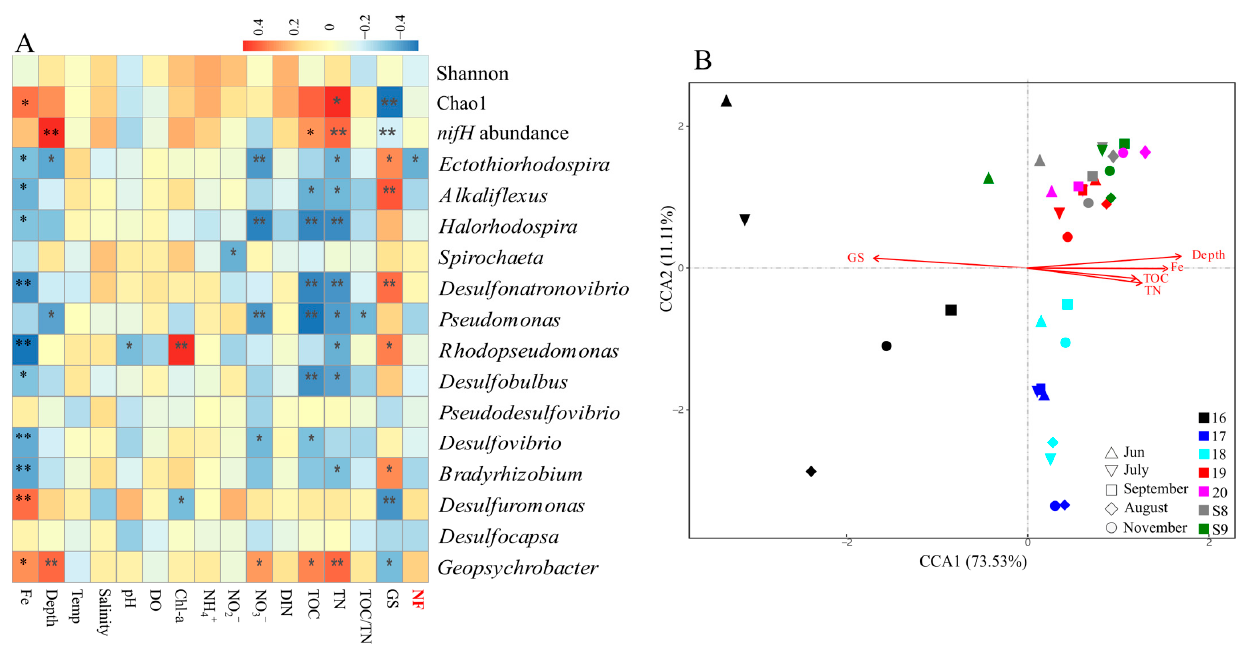
Figure 7. ( a ) Heatmap demonstrated correlations (Spearman’s or Pearson’s) of the nifH gene alpha-diversity index, abundance, and dominant groups with environmental factors and potential nitrogen fixation rates (NF). Significant correlation coefficient at * p ≤ 0.05, ** p ≤ 0.01. ( b ) Canonical correspondence analysis (CCA) shows the significant explaining factor for nifH gene community structure ( p < 0.05).